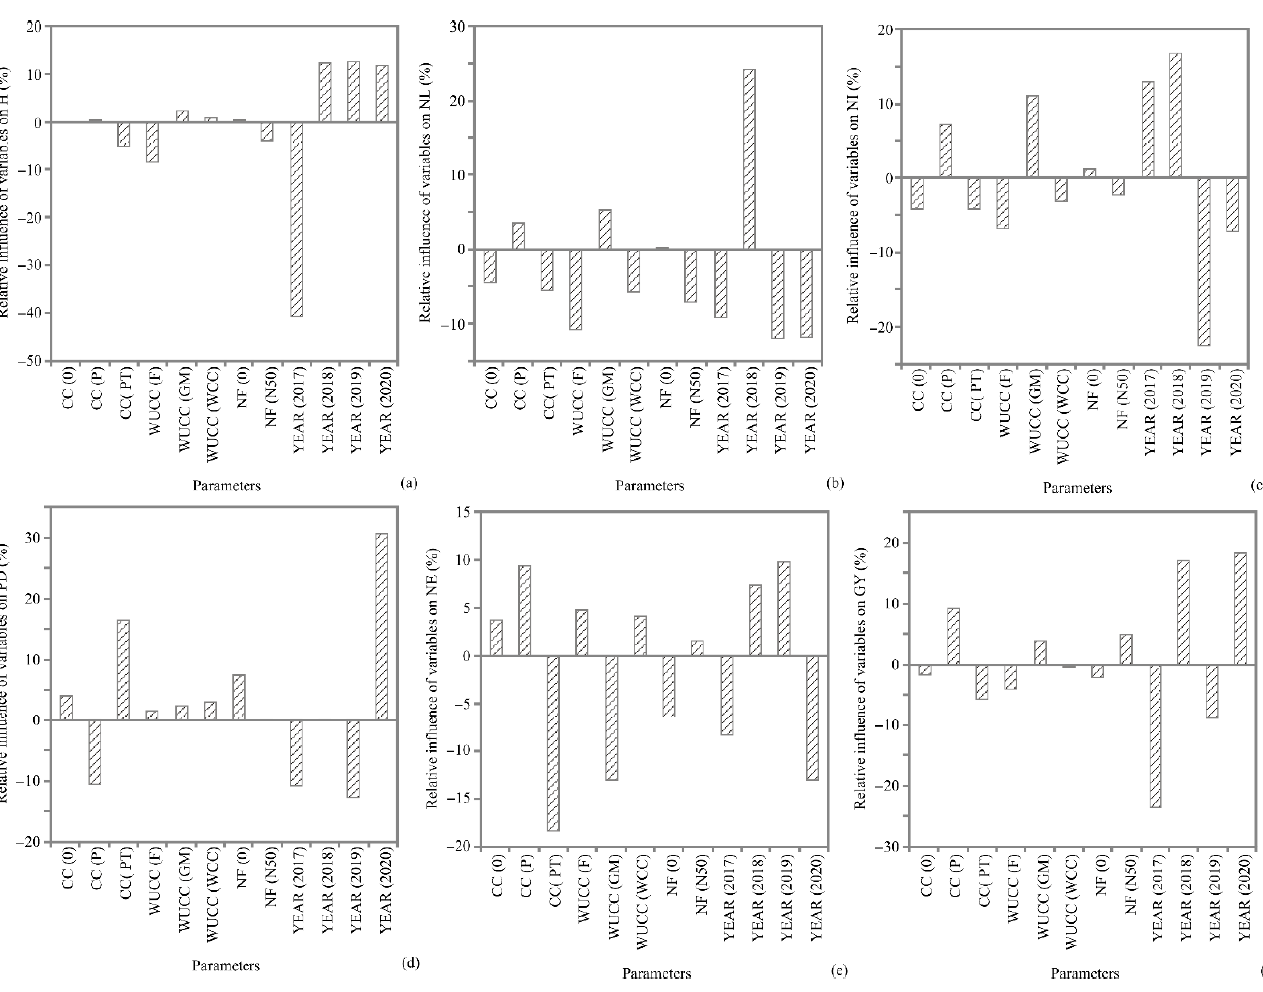
Figure 6. The relative influence (%) of CC, WUCC, NF and YEAR on ( a ) H, ( b ) NL, ( c ) NI, ( d ) PD, ( e ) NE, and ( f ) GY, determined using Yoon’s interpretation method.